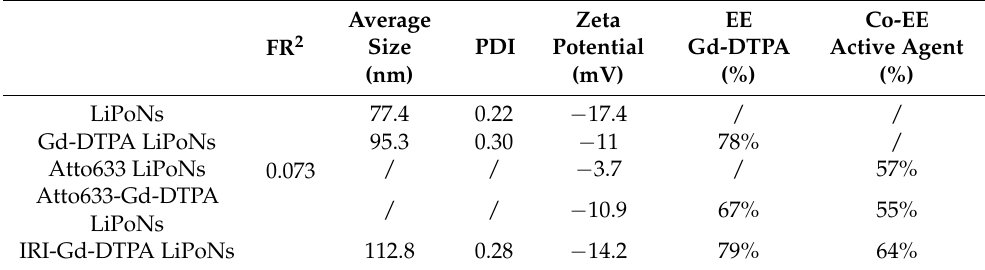
Figure 3. LiPoNs size distribution and morphological characterisation: ( a ) particle size distribution, ( b ) TEM image (stained with osmium smoke) and ( c ) SEM image of LiPoNs performed at optimal conditions, with a Lipids concentration of 0.0072% w/v (mass ratio 8:1 SPC:Chol) dissolved in etOH/Water (65/35% v/v ) and a CH concentration of 0.01% w/v dissolved in acid solution (AcOH ‐ 1 % v/v ) at FR 2 of 0.073. Table 1. Table summary of average size, standard deviation (Dev.St.), zeta potential and co ‐ encap ‐ sulated efficacy for different LipoNs formulations.